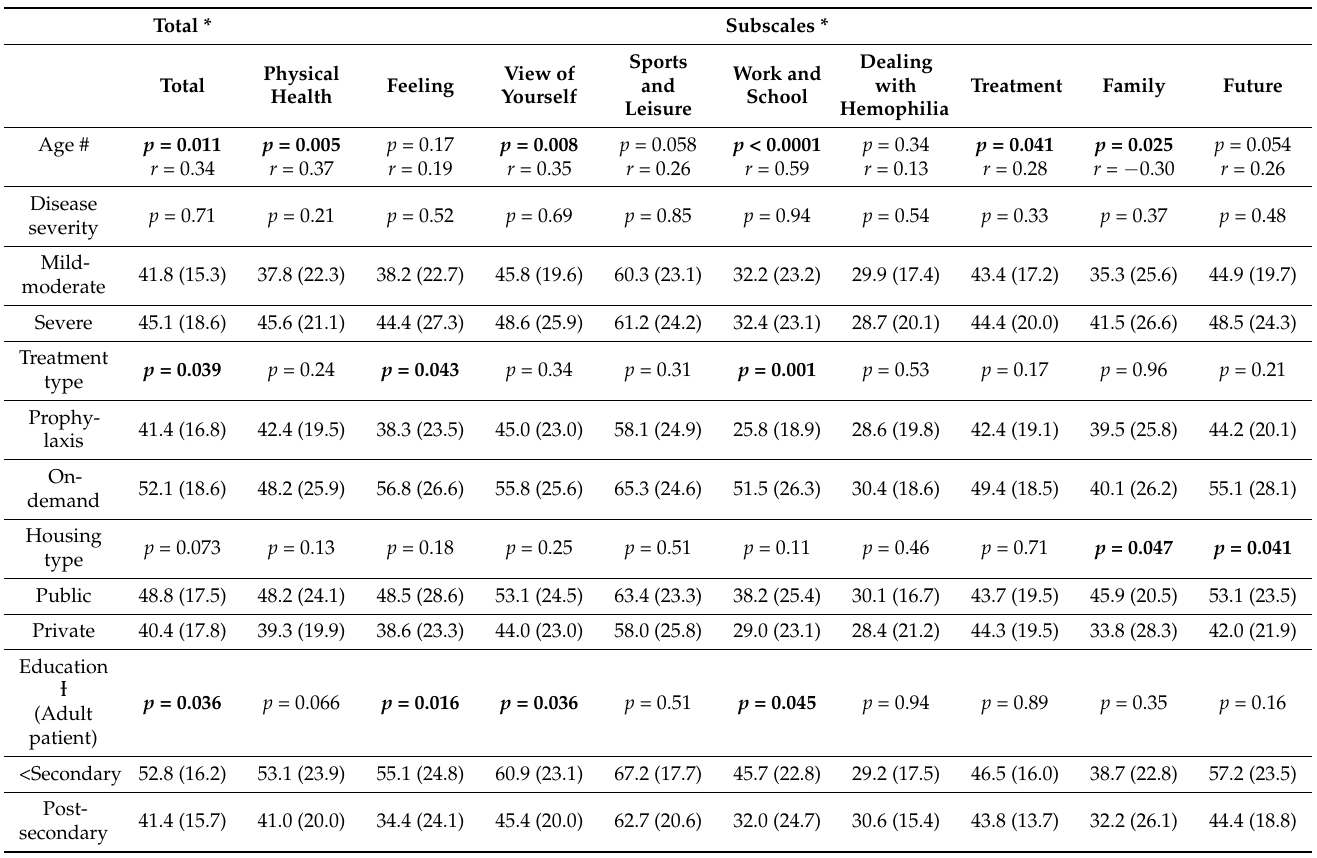
Table 2. Summary and Univariate Comparison of Health-related Quality of Life Outcomes across Clinically Relevant Subgroups.